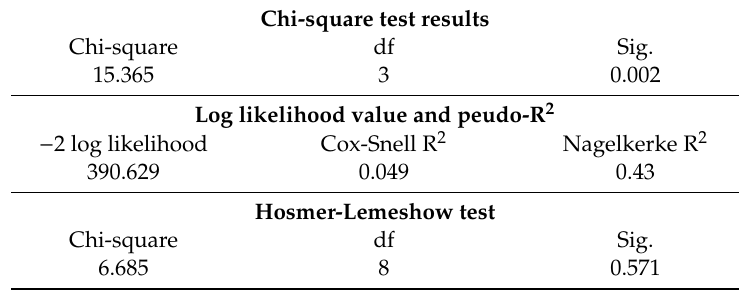
Table 3. Test results and log likelihood value and pseudo-R 2 for the model of the risk of low